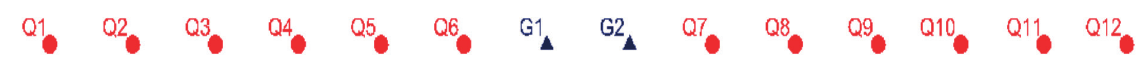
Figure 4. Test confi guration where G1 and G2 are the two geophones installed and Q1-12 are the holes with explosive charges.